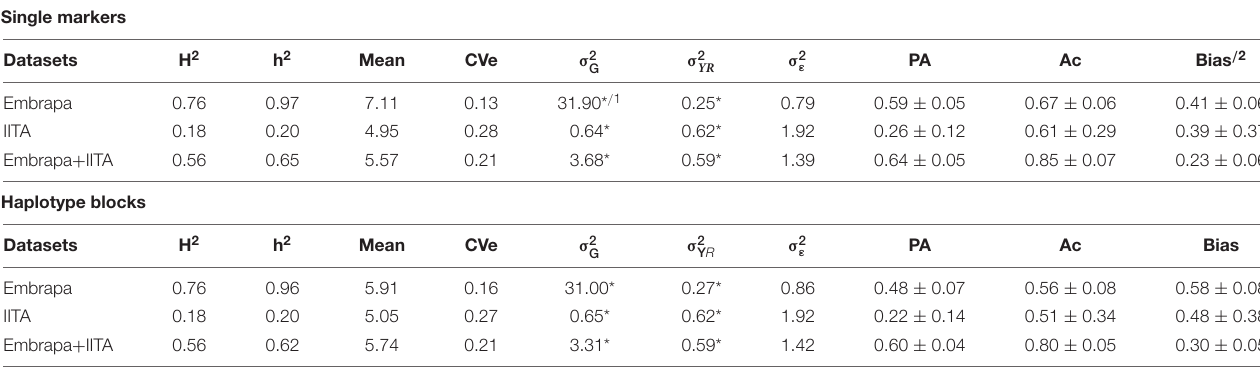
TABLE 5 | Estimates of phenotype-based heritability (H 2 ), SNP-based heritability or haplotype-based heritability (h 2 ), predicted mean, coefficient of residual variation (CVe), genetic variance ( σ